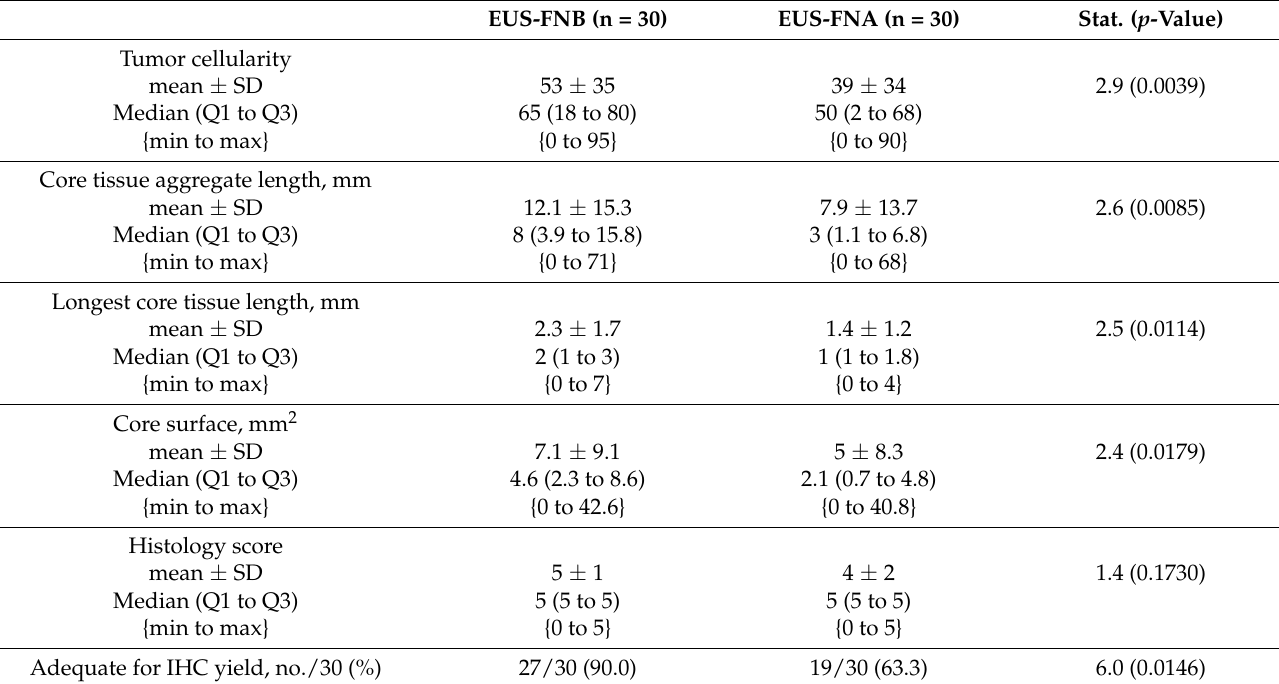
Table 3. Diagnostic metrics in EUS - FNB and EUS -FNA samples.